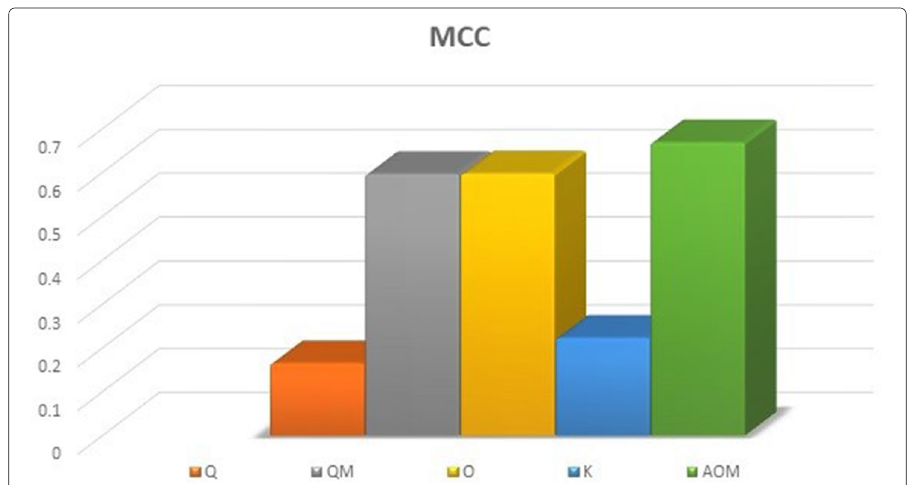
Fig. 14 This figure represents the average of the Matthews correlation coefficient (MCC) for quantum entropy, modified quantum entropy (proposed), Otsu, Kapur method, and the hybrid of the proposed and Otsu,